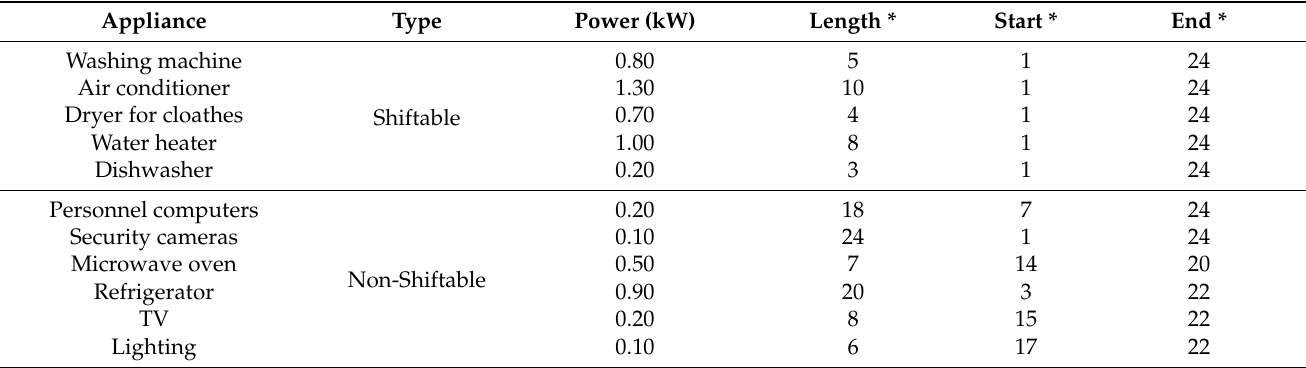
Table 2. Start, end and operation times of the appliances in